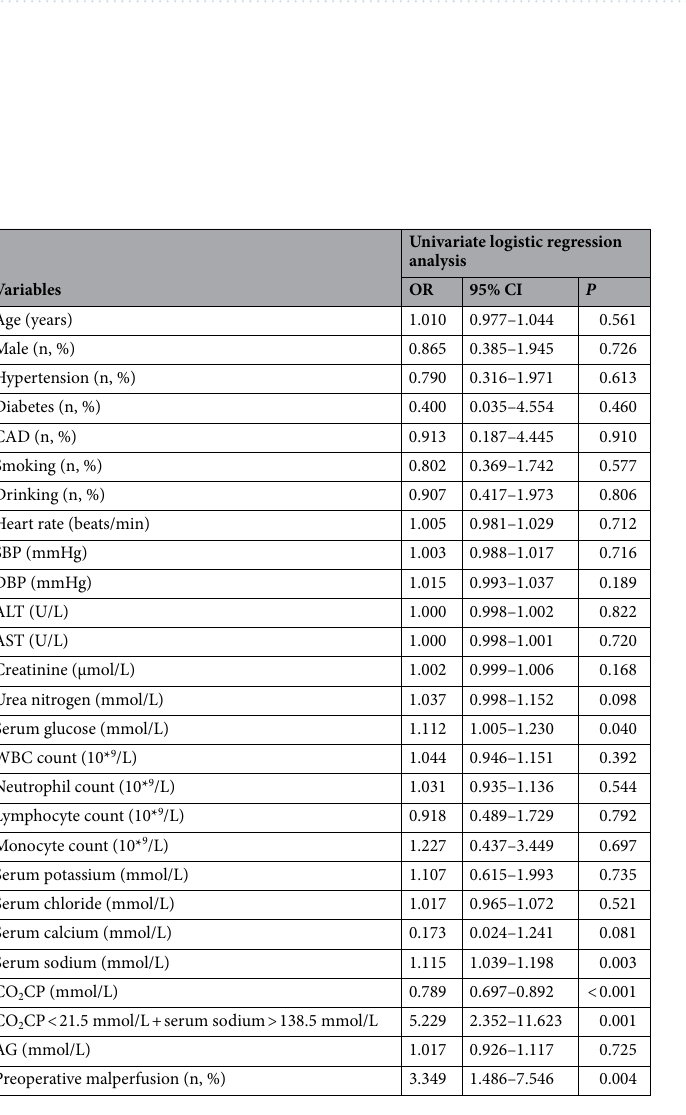
Table 4. Independent predictors of mortality in univariate logistic regression analysis. CAD coronary artery disease, SBP systolic blood pressure, DBP diastolic blood pressure, ALT alanine transaminase, AST